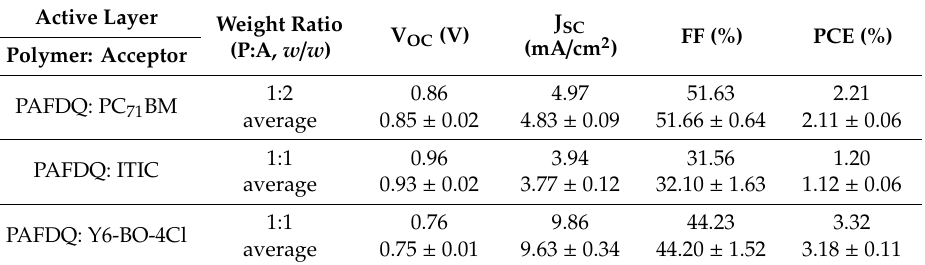
Table 2. Photovoltaic performance of the OSCs.